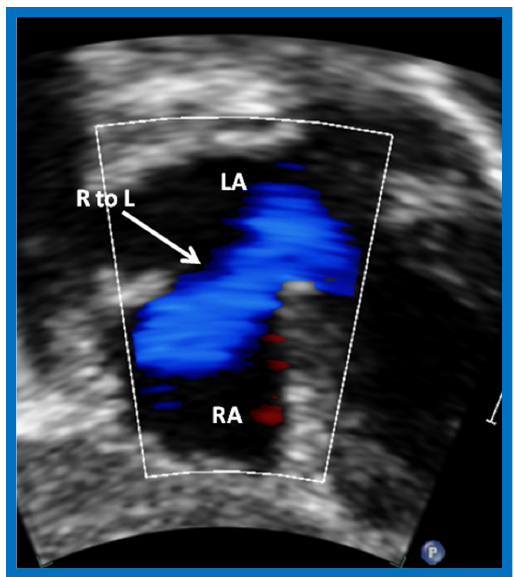
Figure 19. Selected video frame from subcostal view of a neonate with tricuspid atresia demonstrating right-to-left (R to L) shunt (arrow) across the interatrial communication. LA, Left atrium; RA, Right atrium. Reproduced from Rao P.S. [39].